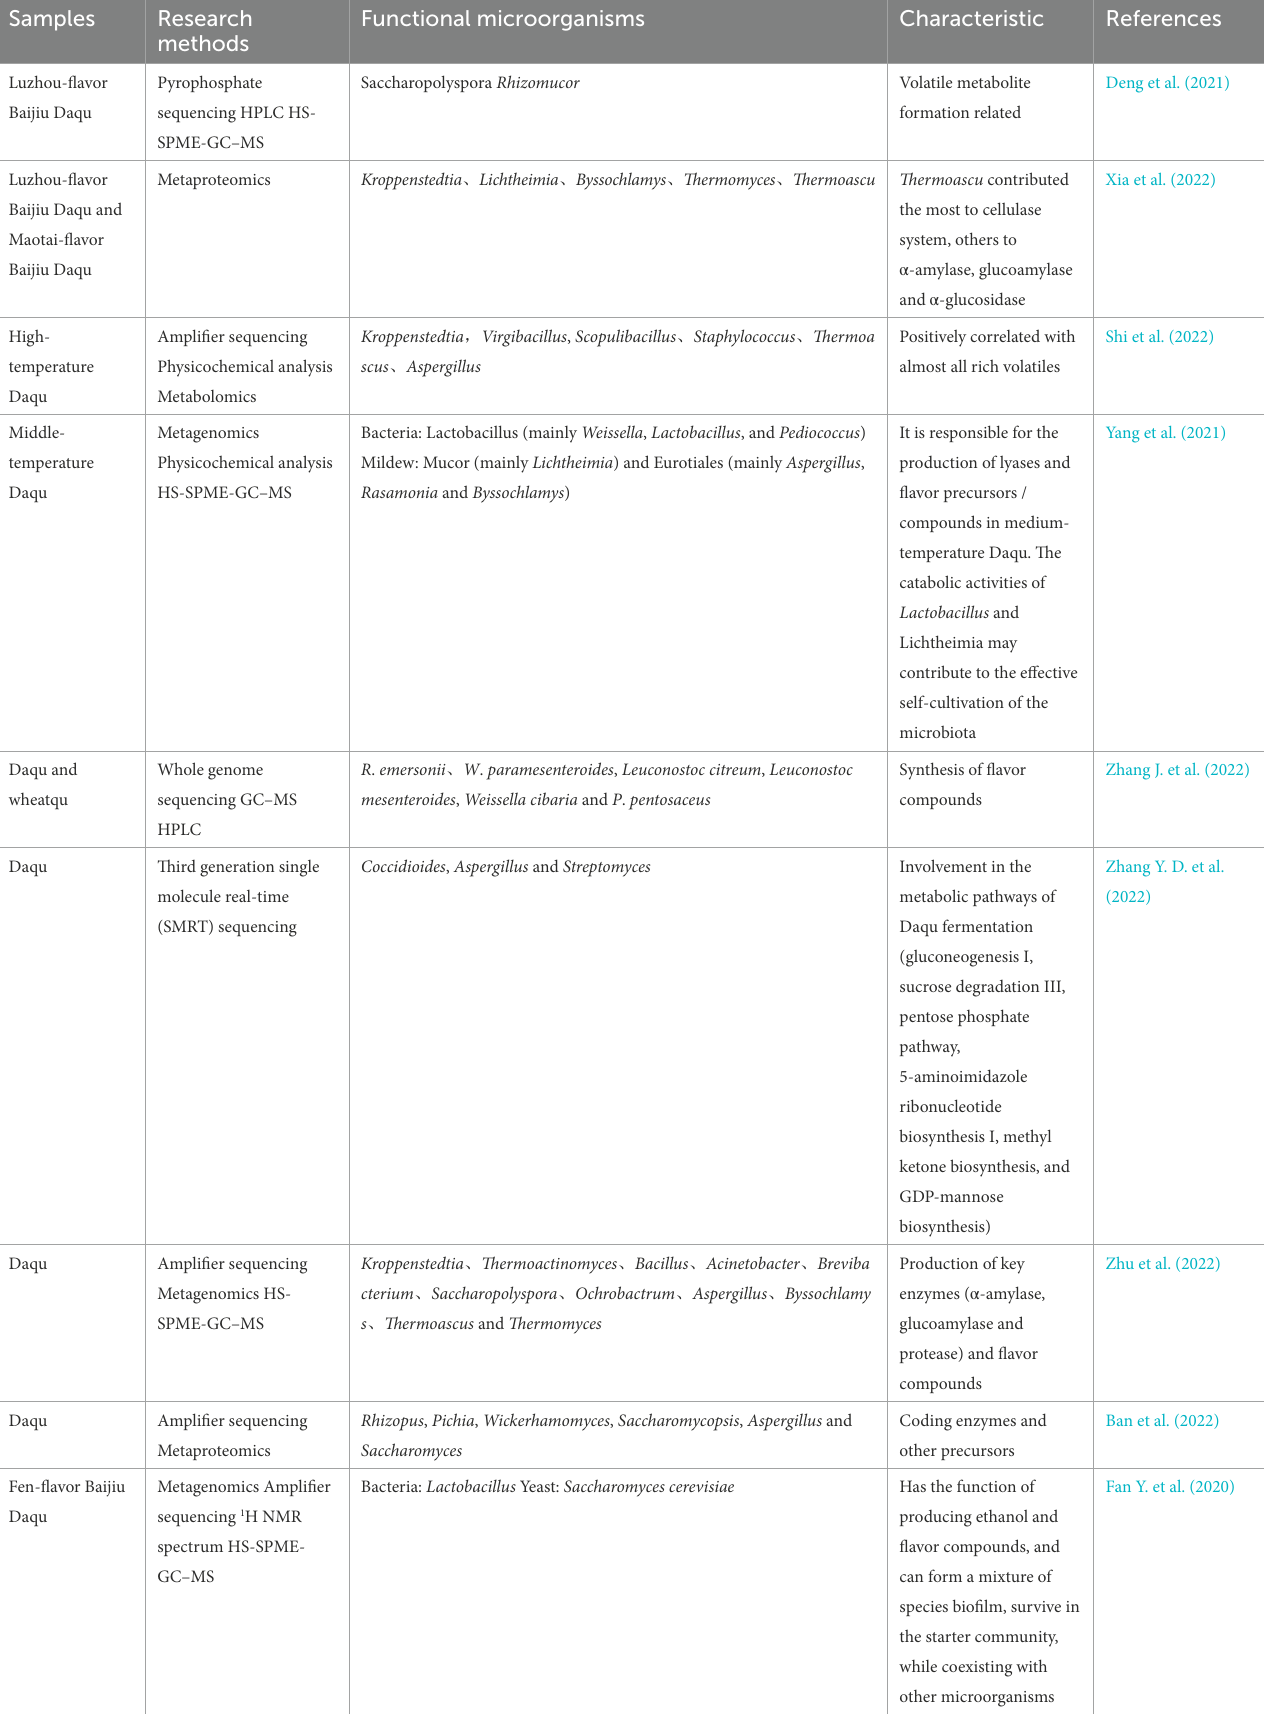
TABLE 2 Composition, functional characteristics, and research methods of core functional microbiota.